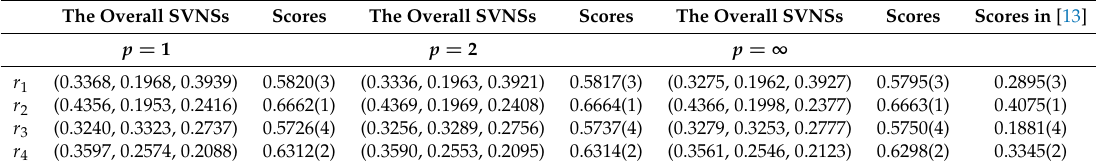
Table 3. The overall SVNSs and associated rankings (in parentheses) with respect to completely unknown attribute